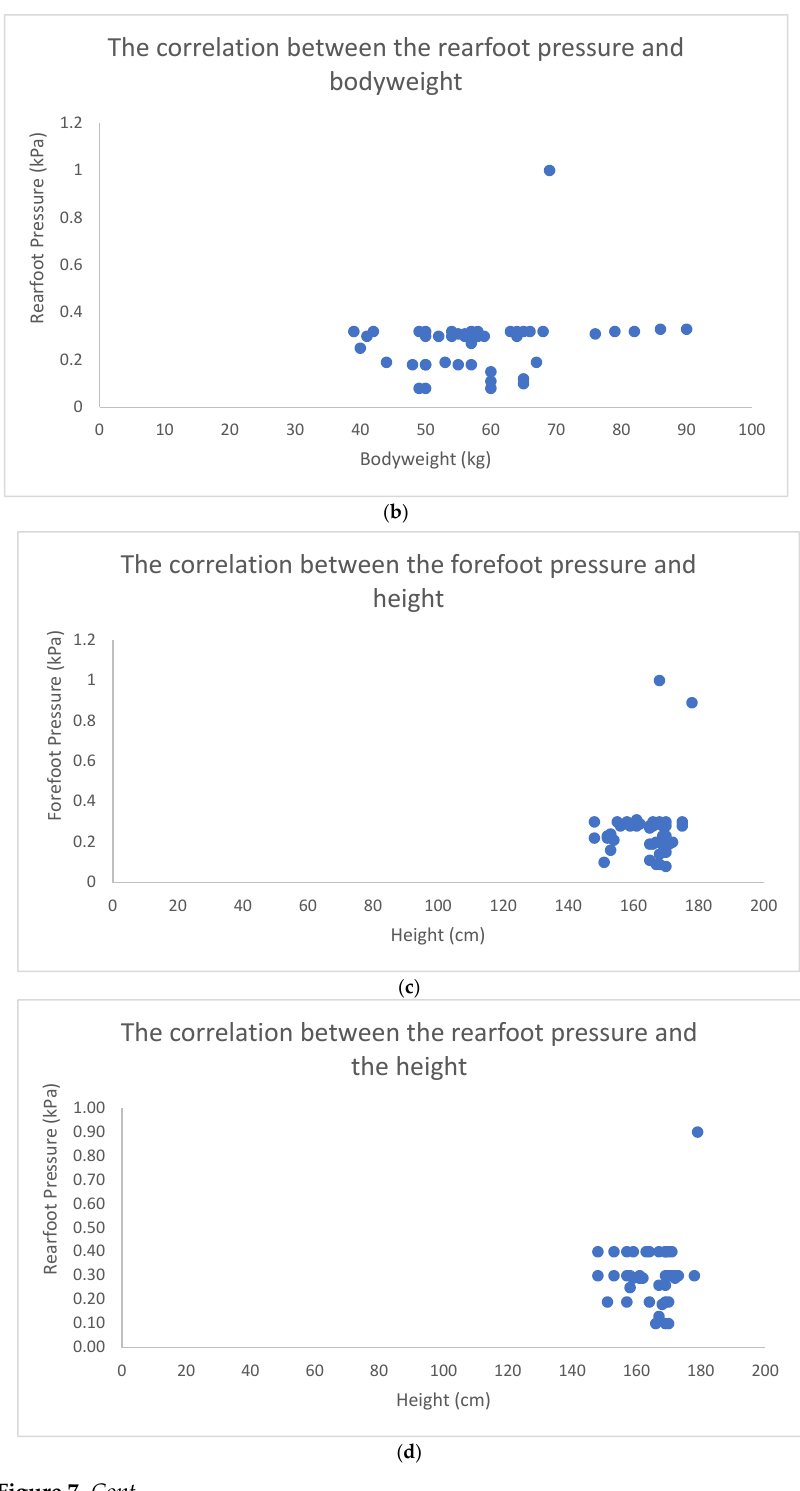
The tendency of weight bearing on rearfoot and forefoot Figure 7. Cont